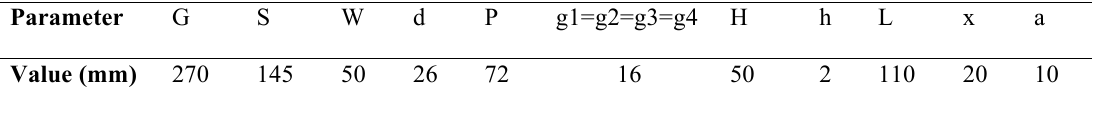
Table 1. The optimized geometrical parameters of proposed